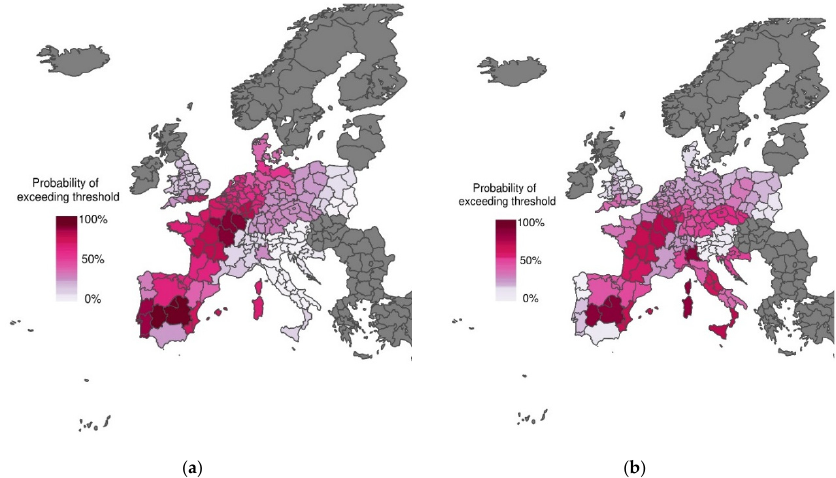
Figure 1. ( a ) Probabilistic map of exceeding emergency daily mortality threshold (75th percentile of daily mortality distribution in the warm tail) using a mortality model driven with observed apparent temperature data during the heat wave scenario (1 – 15 August 2003); ( b ) Corresponding observations for the same period. The graduated colour bar represents the probability of exceeding the mortality threshold (ranging from 0%, pale colours, to 100%, deep colours). Source: [19]. Int. J. Environ. Res. Public Health 2016 , 13 ,